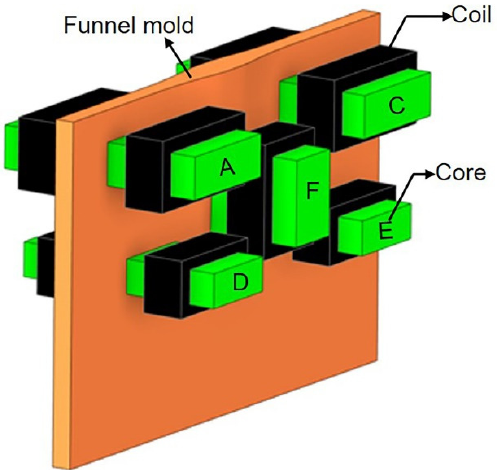
Figure 1. 3D geometric model of FTSC FM with EMBr device and magnetic pole names.